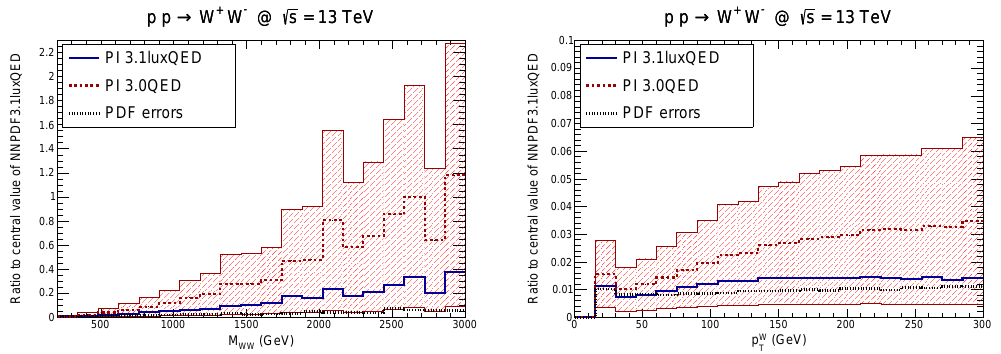
Figure 4.5: Same as Fig. 4.3 for the production of a W + W − pair, specifically for invariant mass distribution m (left) and the transverse momentum of W bosons p W WW